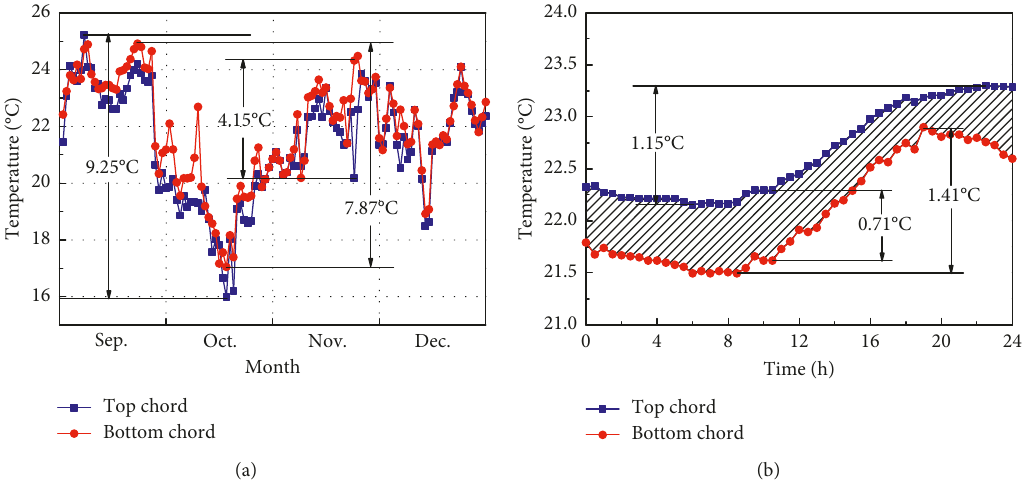
Figure 10: Temperature variation: (a) temperature variation from 1 Sep. 2017 to 31 Dec. 2017 at 12:00; and (b) temperature variation from 0: